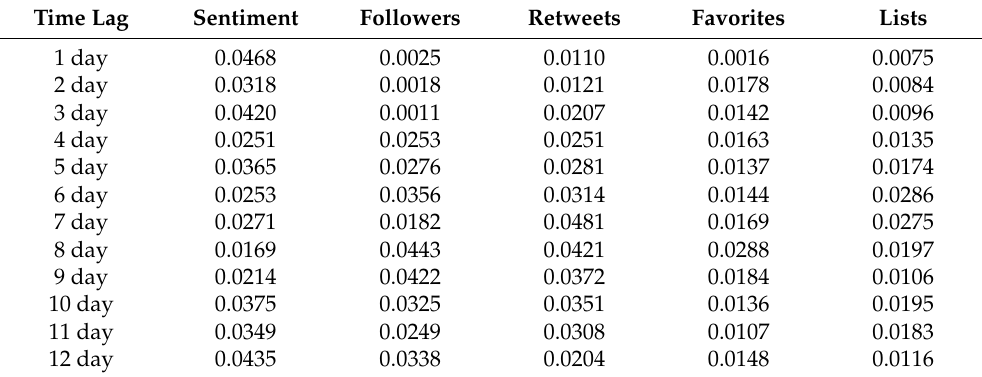
Table 7. Statistical significance ( p -values) of bivariate Granger causality correlation for Bitcoin popularity based on tweet sentiment, followers, retweets, favorites, and lists.